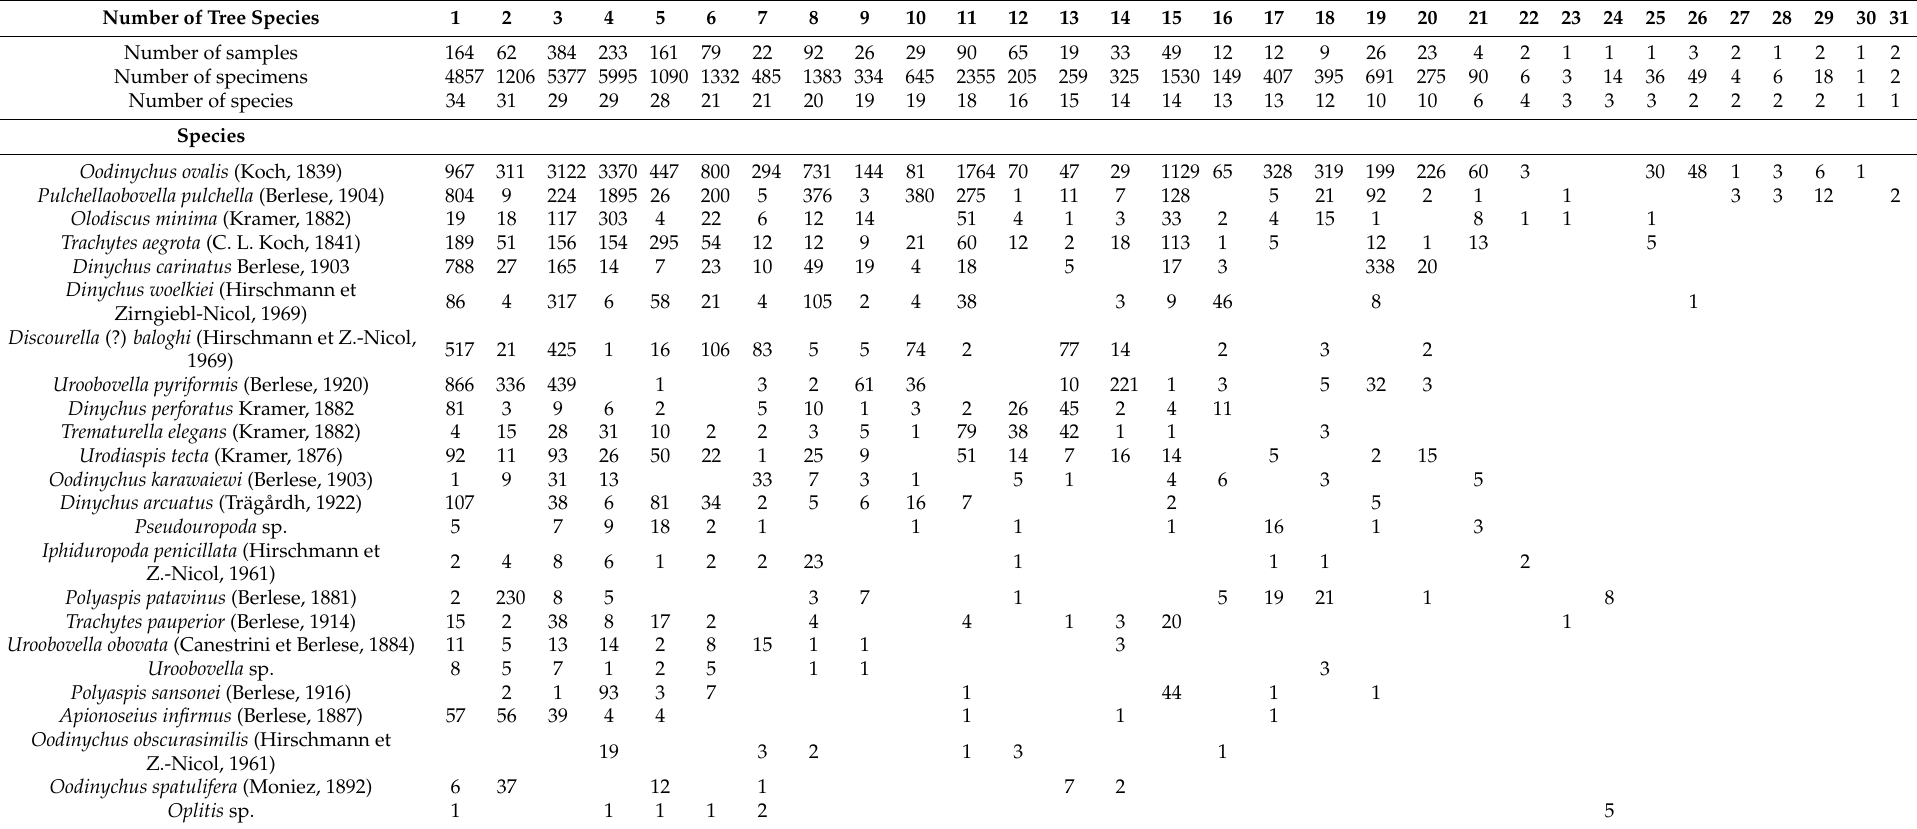
Table A1. Species composition of Uropodina mites in dead wood samples of examined tree species (deciduous vs. coniferous): 1— Fagus L. (beech); 2— Tilia L. (linden); 3— Quercus L.